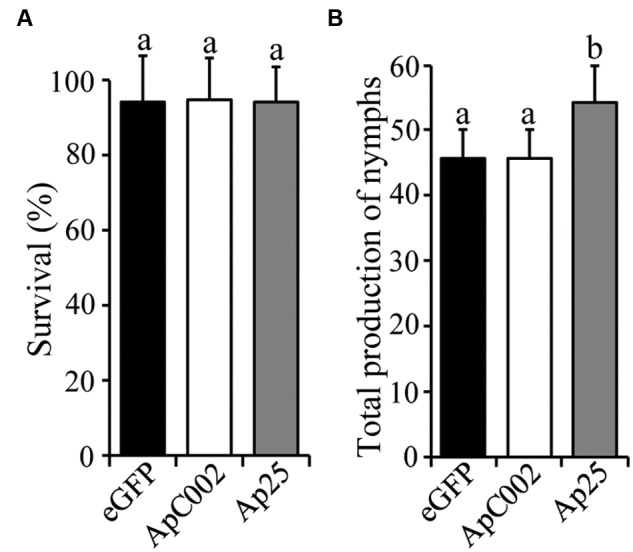
Transient expression of Ap25 promotes reproduction of A. pisum on ZP1109. Leaves of ZP1109 cultivar of P. sativum were syringe-infiltrated with A. tumefaciens AGL-1 carrying the pEAQ-HT-DEST1 plasmid encoding the genes for ACYPI008617 (ApC002; white bar) and ACYPI009919 (Ap25; gray bar), under the control of the CaMV 35S promoter. A. tumefaciens carrying the pEAQ-HT-DEST1 plasmid encoding the gene for enhanced GFP (eGFP; black bar), under the control of the CaMV 35S promoter was used as control. (A) Survival rate of Ar_Po_58 line is not affected by the transient expression of the salivary genes ApC002 and Ap25. At 3 days post infiltration, six new-born aphids were clip caged on agroinfiltrated leaves and counted when aphids were adults (8 days-old) to check the survival rate. Bars show the average percentage of survivors plus the standard deviation of 20 biological replicates. After the survival test, one aphid per plant was kept and placed on a new 3-day-post-infiltrated leaf to check the fecundity. (B) The transient expression of different genes influenced aphid nymph production. Bars show the average number of nymphs produced plus the standard deviation of 20 biological replicates. Different letters indicate significant differences between groups.